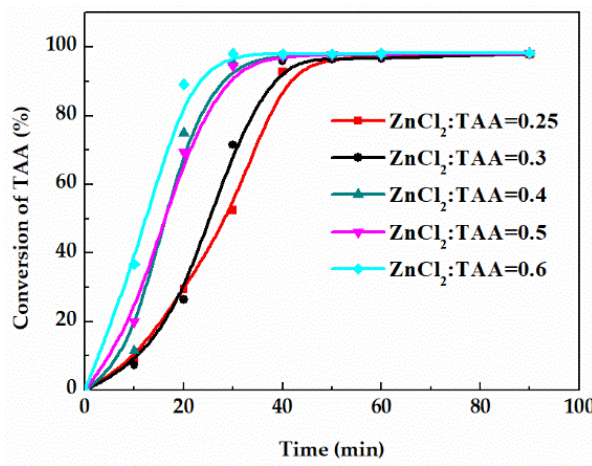
Figure 6. Effect of catalyst amount on the conversion of TAA.